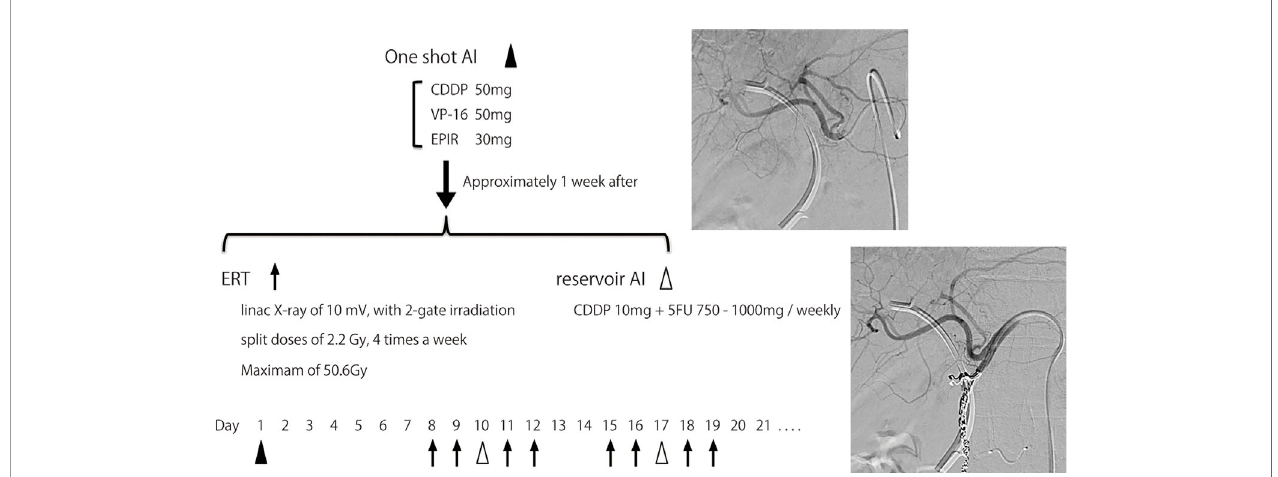
FIGURE 1 | Process of AI+RT combination therapy. One-shot AI consisted of cisplatin 50 mg, etoposide 50 mg and epirubicin 30 mg (EEP therapy). Approximately 1 week after one-shot AI, external beam radiation therapy (ERT) was started. ERT used linac X-ray of 10 mV, with 2-gate irradiation administered to the target as split doses of 2.2 Gy, 4 times a week, with a maximum of 50.6 Gy. The irradiation fi eld includes from the pancreas head to the liver duodenum ligament, focusing on the primary tumor. The reservoir system of AI was embedded in the subcutaneous of the groin area almost at the same time as ERT was started. A catheter was placed by the gastroduodenal artery (GDA) coil method, and the side hole was positioned near the common hepatic artery. AI from the reservoir (reservoir AI) was performed with FP therapy (5FU 750-1,000 mg + cisplatin 10 mg) once a